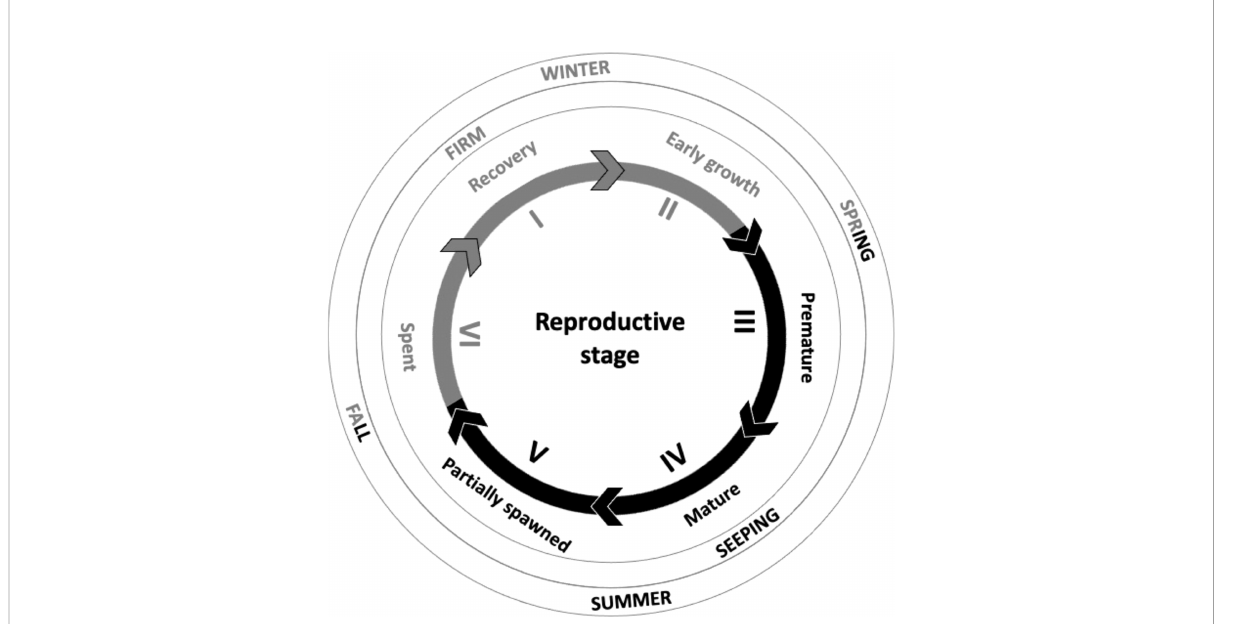
FIGURE 1 Schematic of the reproductive stages of a mature sea urchin which are best suited for the seafood market (light grey lines and text) when uni are fi rm and not seeping gametes, and those that are not suited for the market (black lines and text) when near their reproductive peak and uni readily seep gametes. Based on Northern hemisphere species such as Arbacia punctulata, Psammechinus miliaris and Paracentrotus lividus (adapted from Fuji, 1960; Byrne, 1990; Kelly et al., 2000; Suckling et al., 2011; Suckling, 2012). This schematic presents a general overview only, to illustrate how the reproductive cycle can be linked to the market and season, and does not align exactly with seasonal timings for A. punctulata